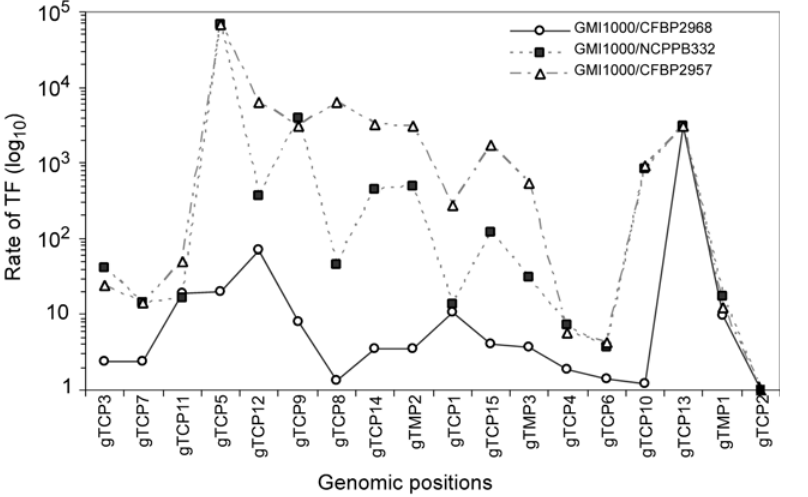
Figure 5. Ratio of recombination frequencies after natural transformation of different distantly R.solanacearumstrains. Total genomic DNA of GMI1000 strain was used as donor with GMI1000, CFBP2968, NCPPB332 and CFBP2957 as recipient strains. These strains CFBP2968, NCPPB332 and CFBP2957 have respectively 98%, 81% and 69% of the GMI1000 genes conserved in their genomes (TCP2 , detection limit). TF, transformation frequency.